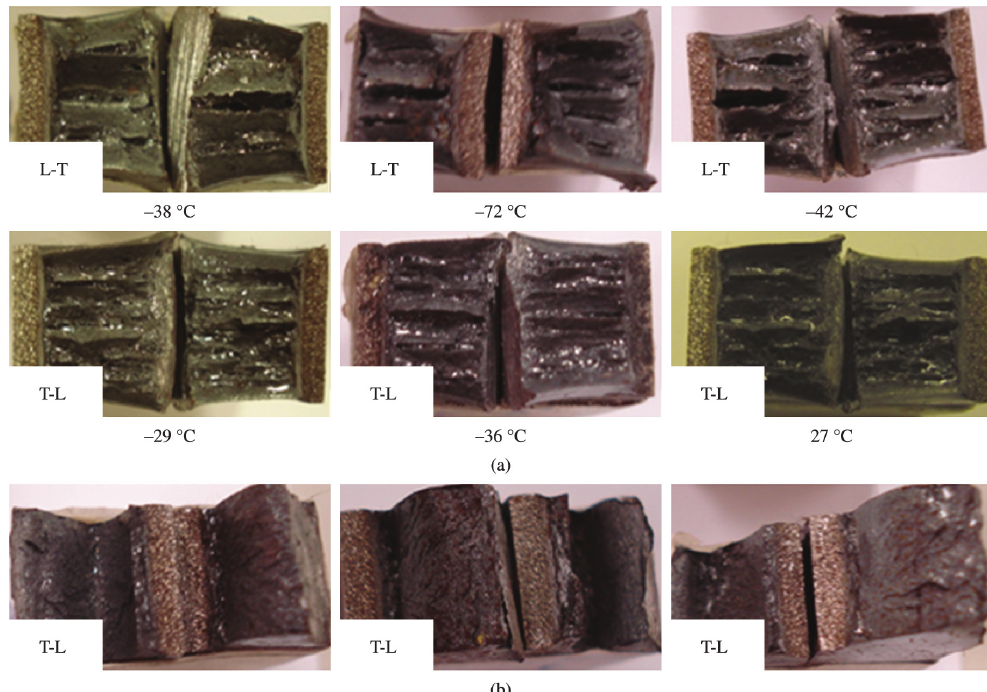
Figure 9. Fractured surfaces from the L-T and T-L orientation showing characteristic of delamination: a) crack-divider type; and b) crack- arrester type.